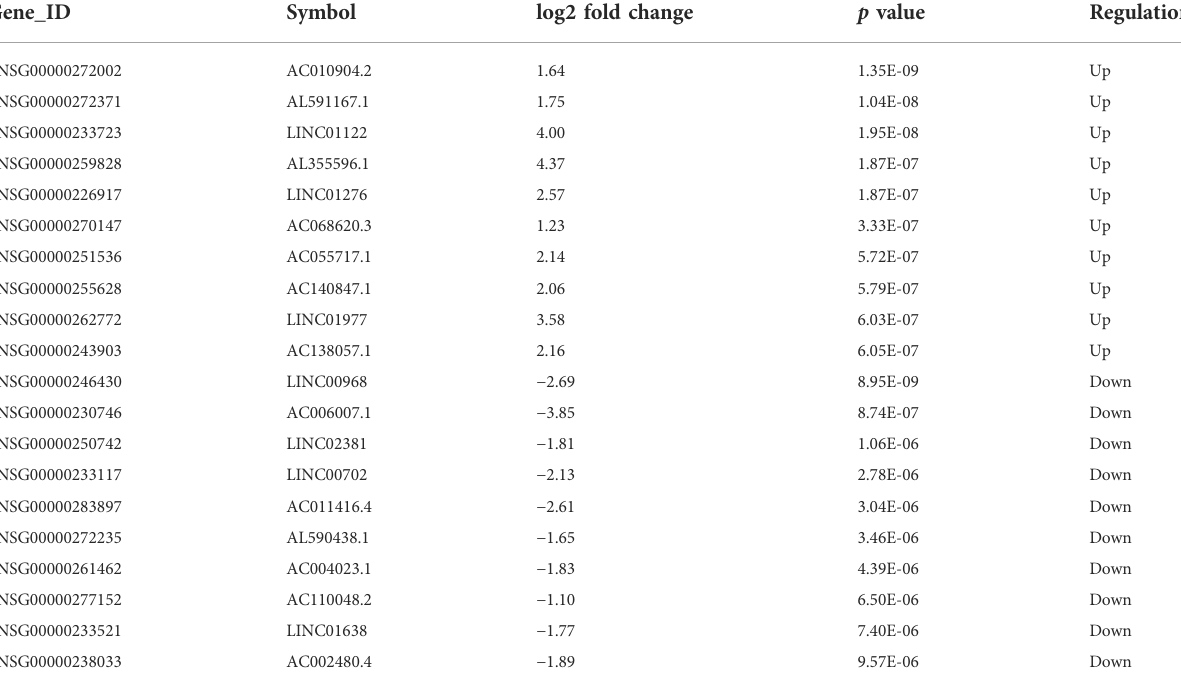
Count: the number of DEGs that hit in the